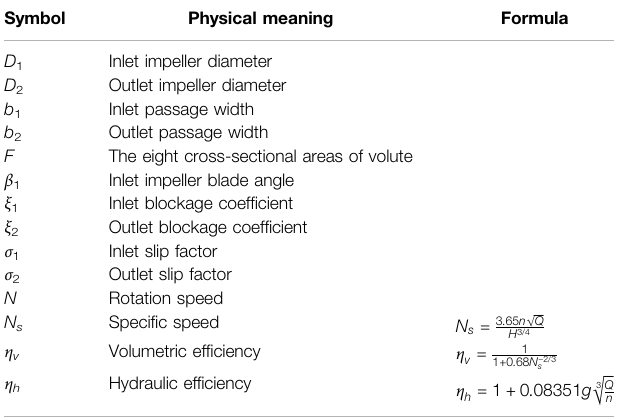
FIGURE 1 | Acceptable limits for PAT prediction.